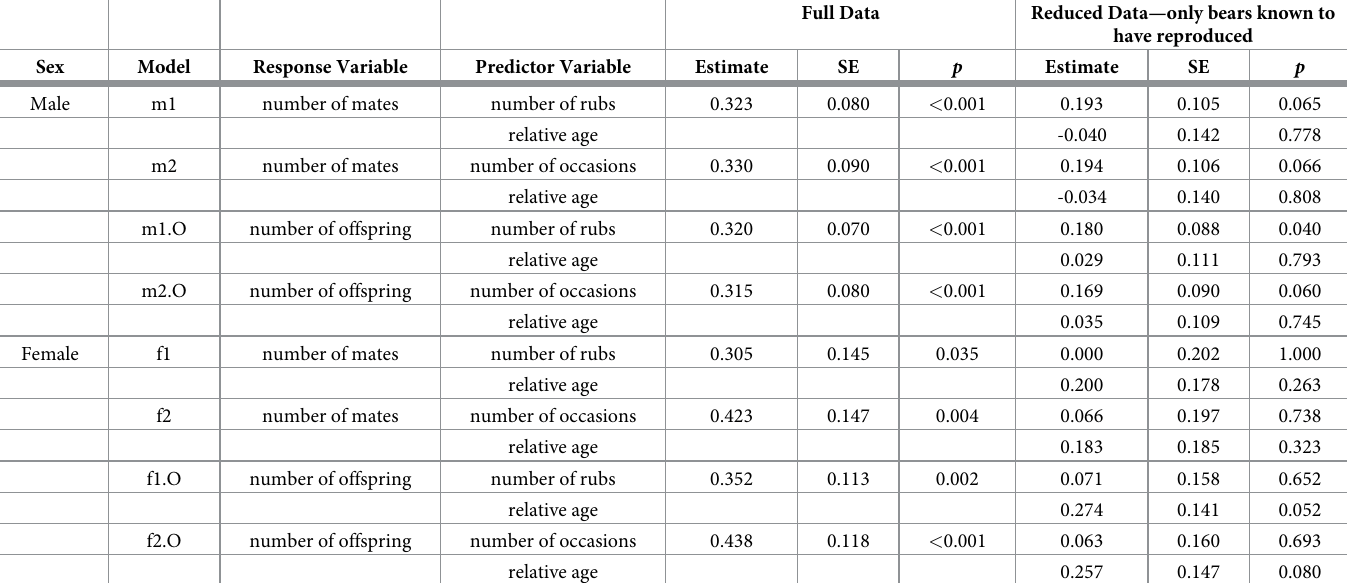
Table 1. Poisson regression model results for the relationship between mates, offspring, and the number of rub objects at which and sampling occasions during which male and female brown bears were detected. Data are from southwestern Alberta 2011–2014.